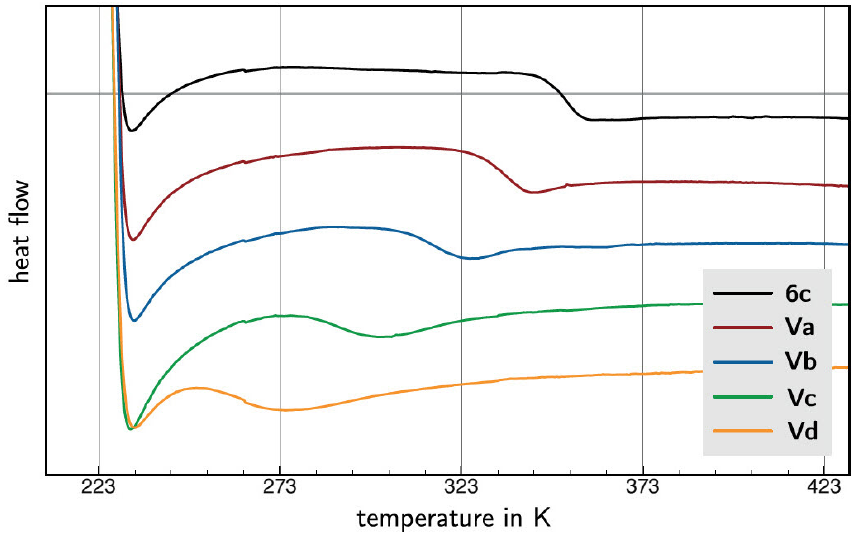
Figure 6. DSC curves of polymer samples 6c and Va – Vd ; curves are shifted vertically for